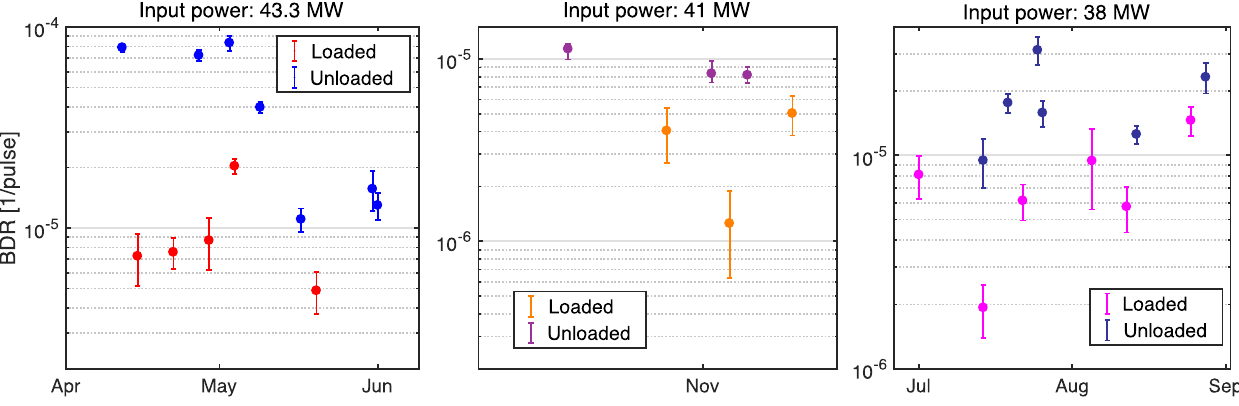
FIG. 4. Measured BDR with alternating beam presence at different input power: 43.3 MW (left), 41 MW (center) and 38 MW (right). The run presenting the minimum number of breakdowns has recorded four, and normally tens of breakdowns are recorded per experiment. The error bars represent the statistical